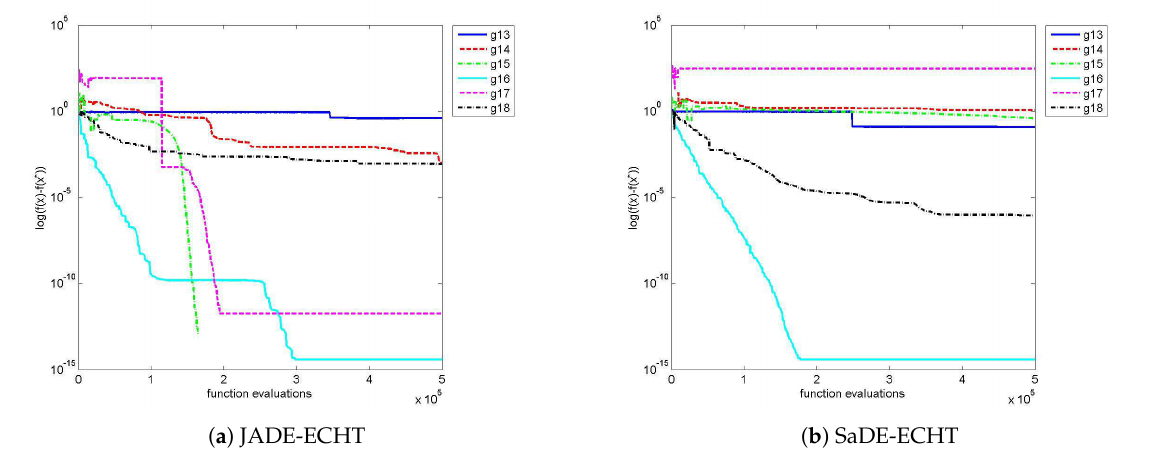
Figure 7. Convergence comparison of JADE-ECHT and SaDE-ECHT for g13–g18.